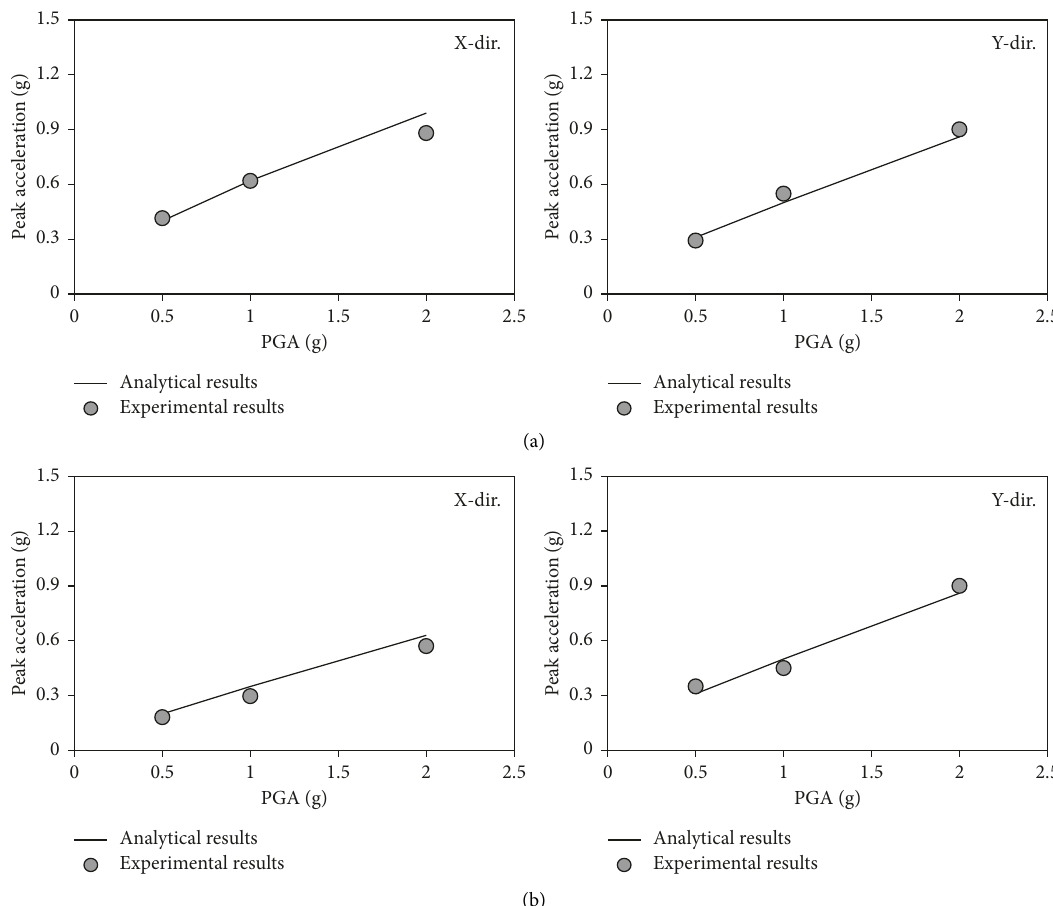
Figure 21: Peak acceleration vs. PGA at the transformers of the UPS specimens, as obtained from the experimental and analytical results. (a) Series A. (b) Series